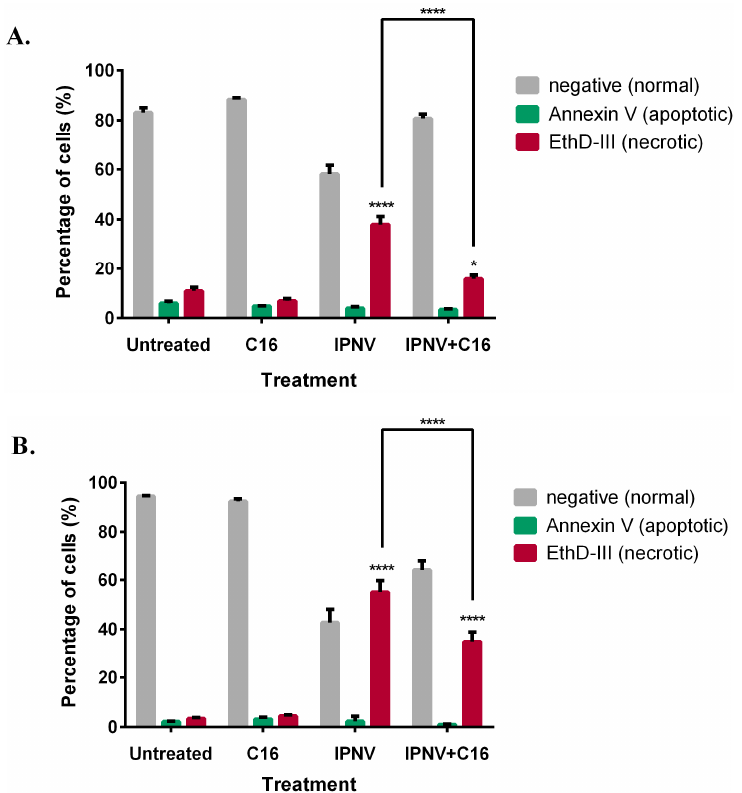
Figure 6. PKR induced membrane damage promotes virus release from infected cells. CHSE-214 ( A ) and TO ( B ) cells were infected with IPNV for 24 h in the presence or absence of the PKR inhibitor C16 and apoptotic (Annexin-V) or membrane permeability (EthD-III) changes were assessed by flow cytometry as described in the methodology. The number of cells with compromised membranes (EthD-III) was significantly reduced by C16 treatment while the number of apoptotic cells (Annexin-V) remained unchanged. Bars represent the mean of three parallels ± SD. Asterisks indicate statistical significance; * p < 0.05, **** p < 0.0001, n = 3.